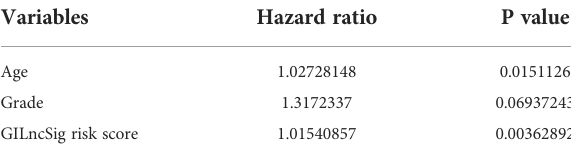
TABLE 5 Multivariate Cox proportional hazard regression analysis using GILncSig risk score, age and grade showed that only GILncSig risk score and age retained their prognostic signi fi